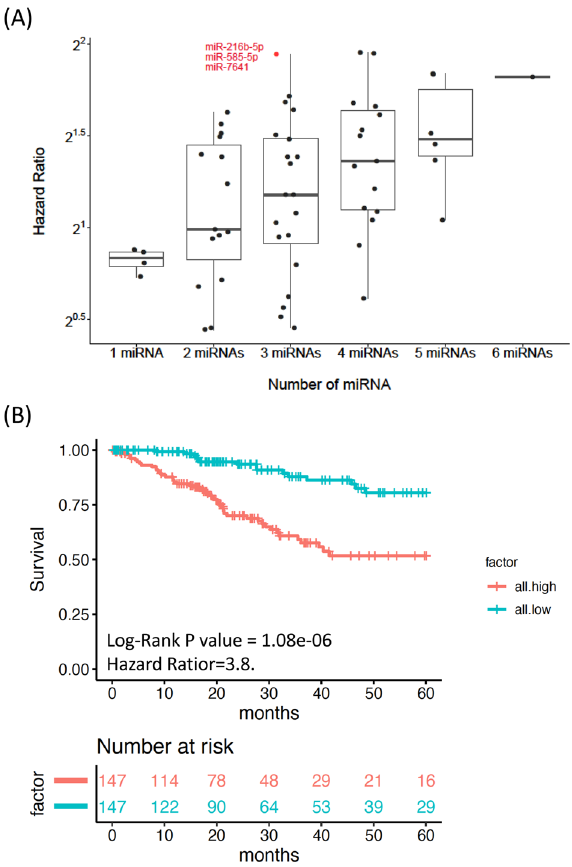
Figure 3. Additive survival analysis of 6 candidate miRNAs. (A) The hazard ratios (HR) of each of the miRNA combinations were calculated by additive survival analysis, as shown by the boxplots with dotplots overlaid. The X-axis indicates the number of miRNAs combined; the Y-axis indicates the log2 transformation of the hazard ratio. The red spot indicates the combination of miR-216b-5p, miR-585-5p, and miR-7641. (B) Survival analysis of the combination of the 3 miRNAs shows a significant difference between the all-high and all-low expression groups with log-rank p-value <